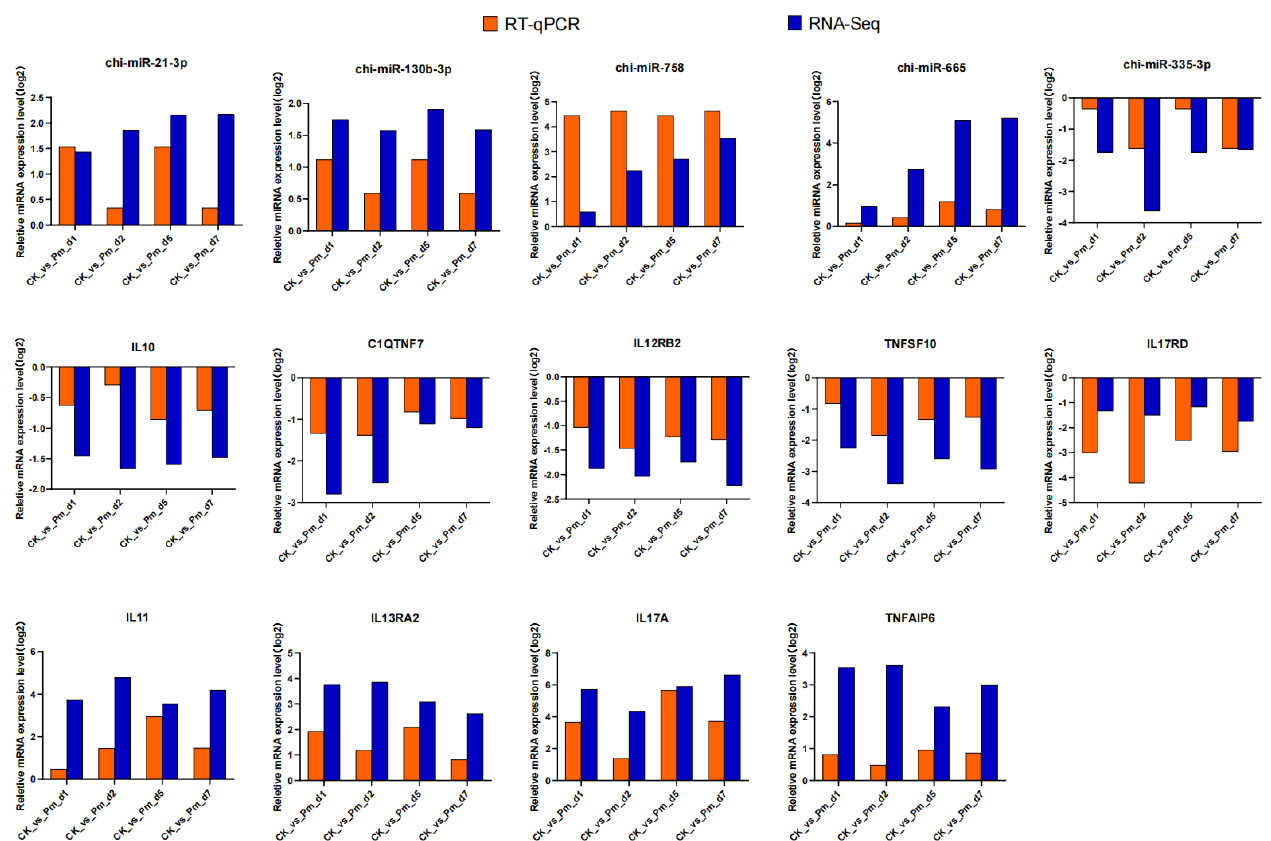
Figure 7. The fold change trend analyses of differentially expressed miRNAs (chi – miR – 21 – 3p, chi